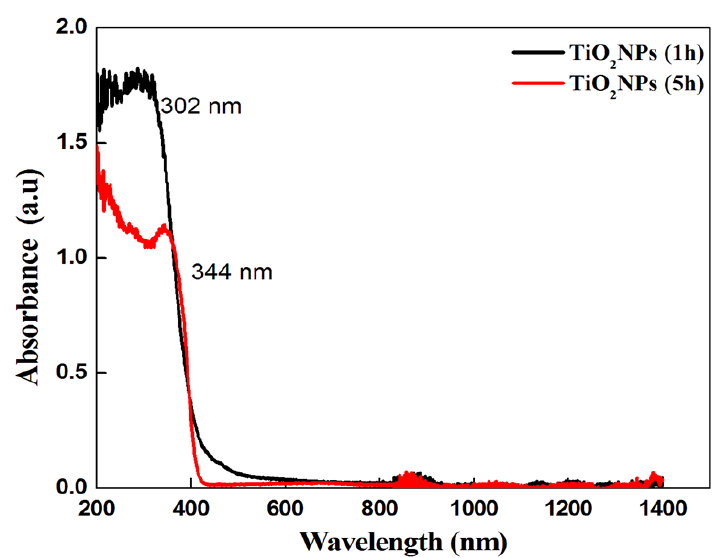
Figure 7. UV-DRS curves of TiO 2 nanoparticles.